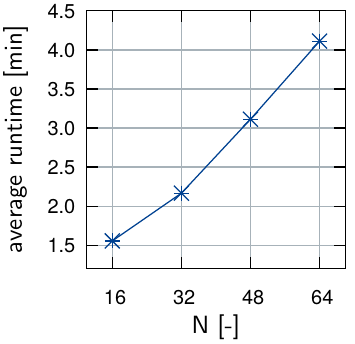
Figure 8. Laptop computer runtimes of the RB model for the fibrous microstructure for various sizes N of the basis. Each data point represents the time needed for all 10 load increments. The spread of the individual times of the 64 validation cases around these average values is negligible.